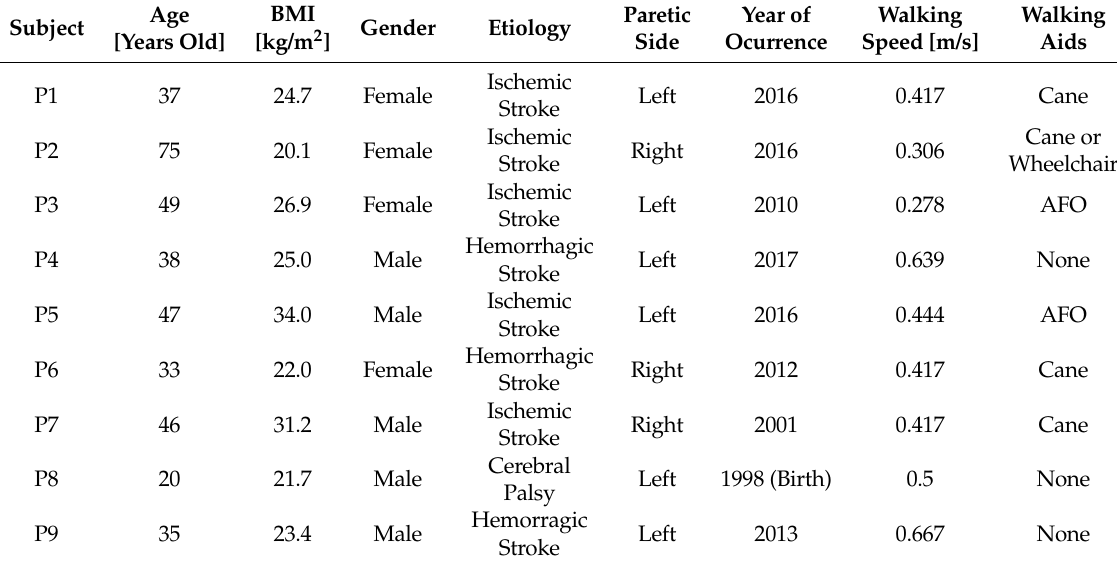
Table 2. Summary of hemiparetic individuals who participated in the study (P group). BMI, body mass